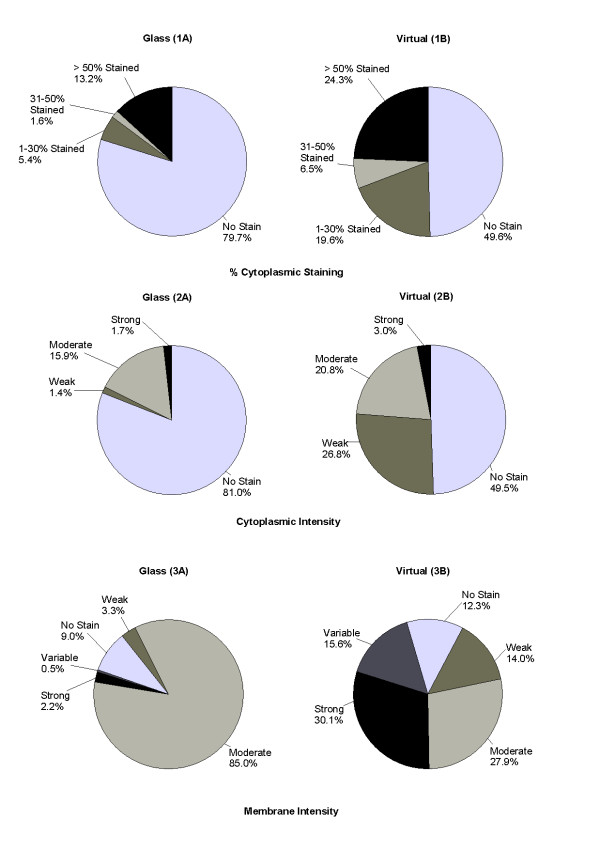
Distribution of the results for virtual and glass TMA reviews of cytoplasmic and membrane staining intensity and cytoplasmic staining. Illustrates the distribution of the classifiers when using virtual and glass methods to (1A) Amount of cytoplasmic staining performed by glass TMA review (1B) Amount of cytoplasmic staining performed by virtual TMA review (2A) Cytoplasmic staining intensity performed by glass TMA review (2B) Cytoplasmic staining intensity performed by virtual TMA review (3A) Membrane staining intensity performed by glass TMA review (3B) Membrane staining intensity performed by virtual TMA review.